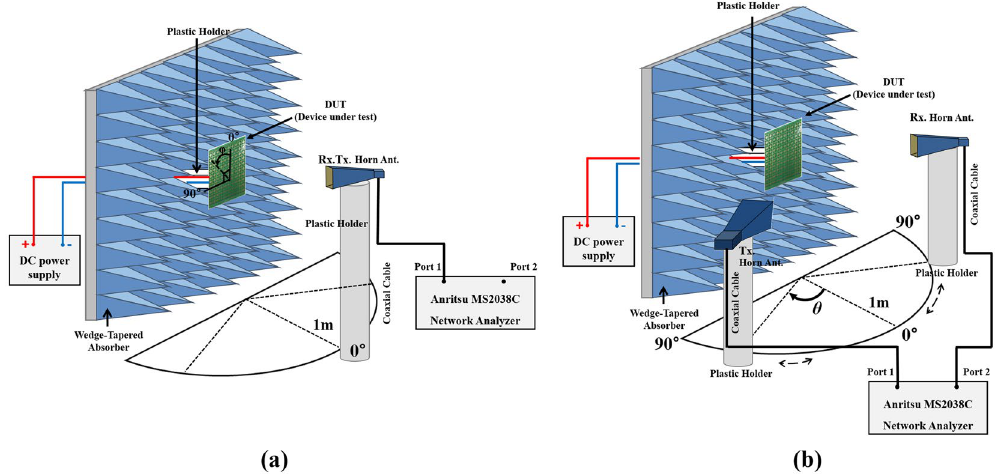
Figure 7. Measurement setup for different (a) polarization angles ( ϕ ) and (b) incident angles ( θ ).